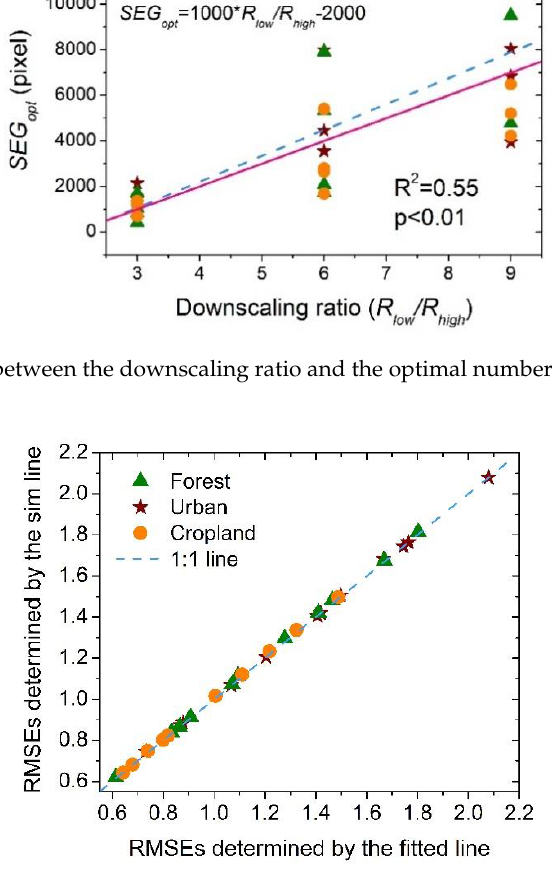
Figure 6. Scatter plot of the RMSEs determined by the fitted line and the simplified fitted line. “sim line” in the y -axis means the simplified fitted line.